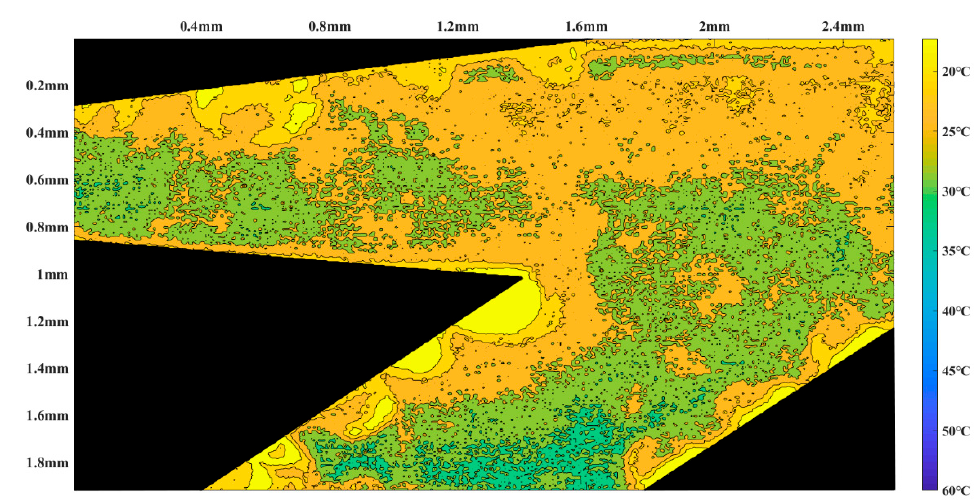
Figure 11. Temperature nephogram in the thermal bubble expansion stage.